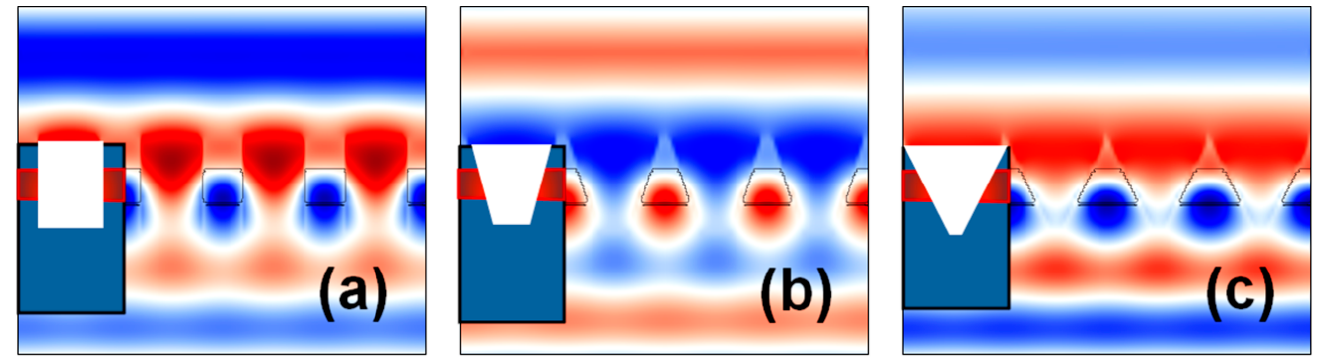
Figure 7. EM field distributions in the PhC structures where the maxima and minima of the EM field are represented by red and blue colors, respectively. ( a ) R t / R b = 0.30/0.30 a . ( b ) R t / R b = 0.40/0.20 a . ( c ) R t / R b = 0.50/0.10 a